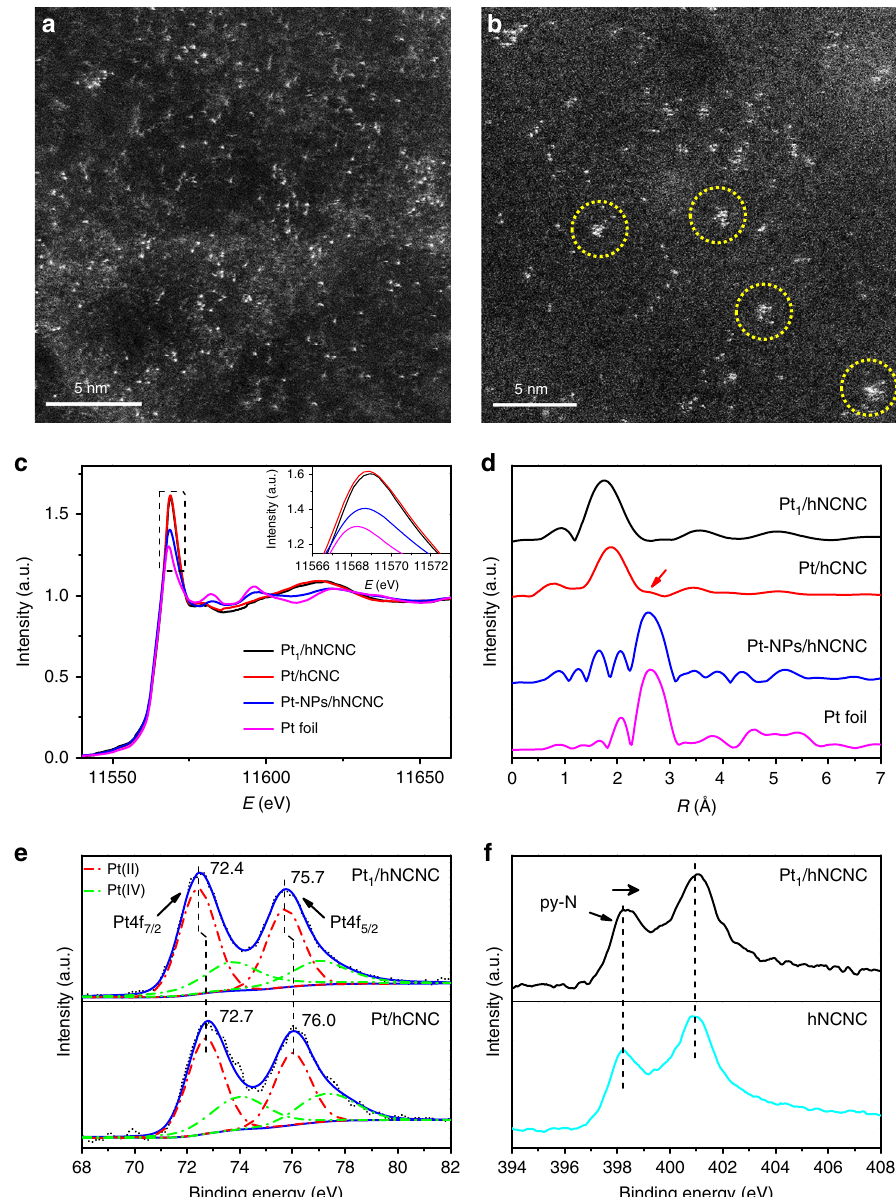
Fig. 1 Morphological and structural characterizations of Pt 1 /hNCNC and Pt/hCNC. a , b HAADF-STEM images of Pt 1 /hNCNC and Pt/hCNC, respectively. The circles in b mark the slight aggregation of Pt atoms. c Normalized XANES spectra at the Pt L 3 edge. Inset is the local enlargement. d k 3 -weighted R- space Fourier transformed spectra from EXAFS. e XPS spectra for Pt 4f. f XPS spectra for N 1s. In ( c , d , and f ), the corresponding data for Pt-NPs/hNCNC, Pt foil and hNCNC are presented for